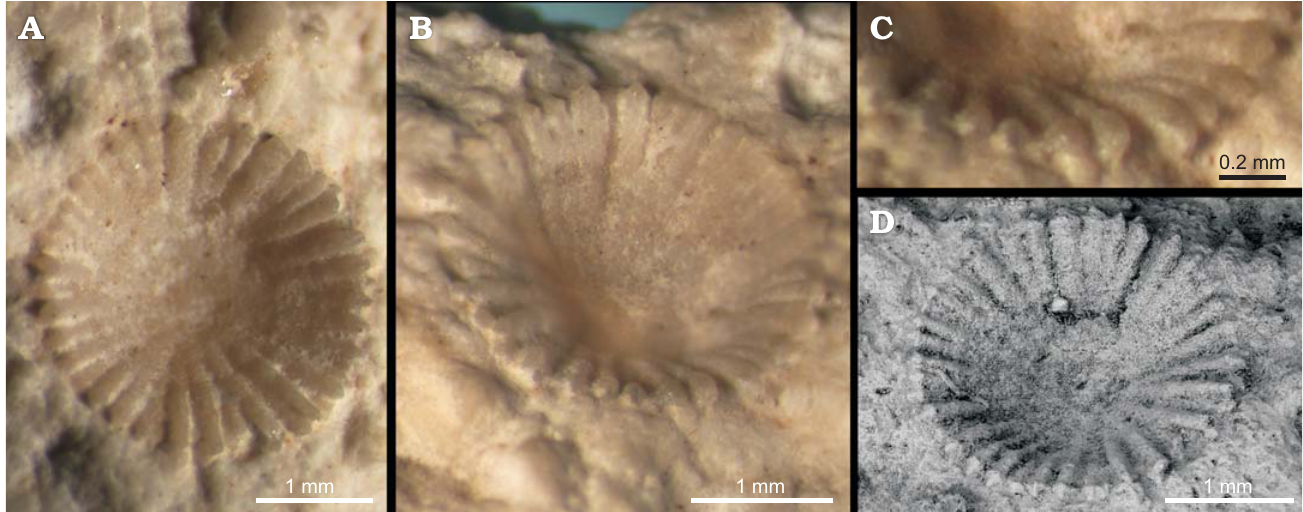
Fig. 7. Operculum of serpulid Pyrgopolon ( Turbinia ?) gaiae sp. nov. from the Sosio Valley, western Sicily (Italy), Wordian to upper Permian, MSNC 4530, holotype. Frontal ( A ) and lateral ( B ) views of the cup. C . Detail of upper side of the cup showing radial ridges endings with cone-shaped teeth regularly spaced (0.15 mm). D . SEM image of the upper side of the cup, the denticulated outer edge forming a nearly continuous ring is